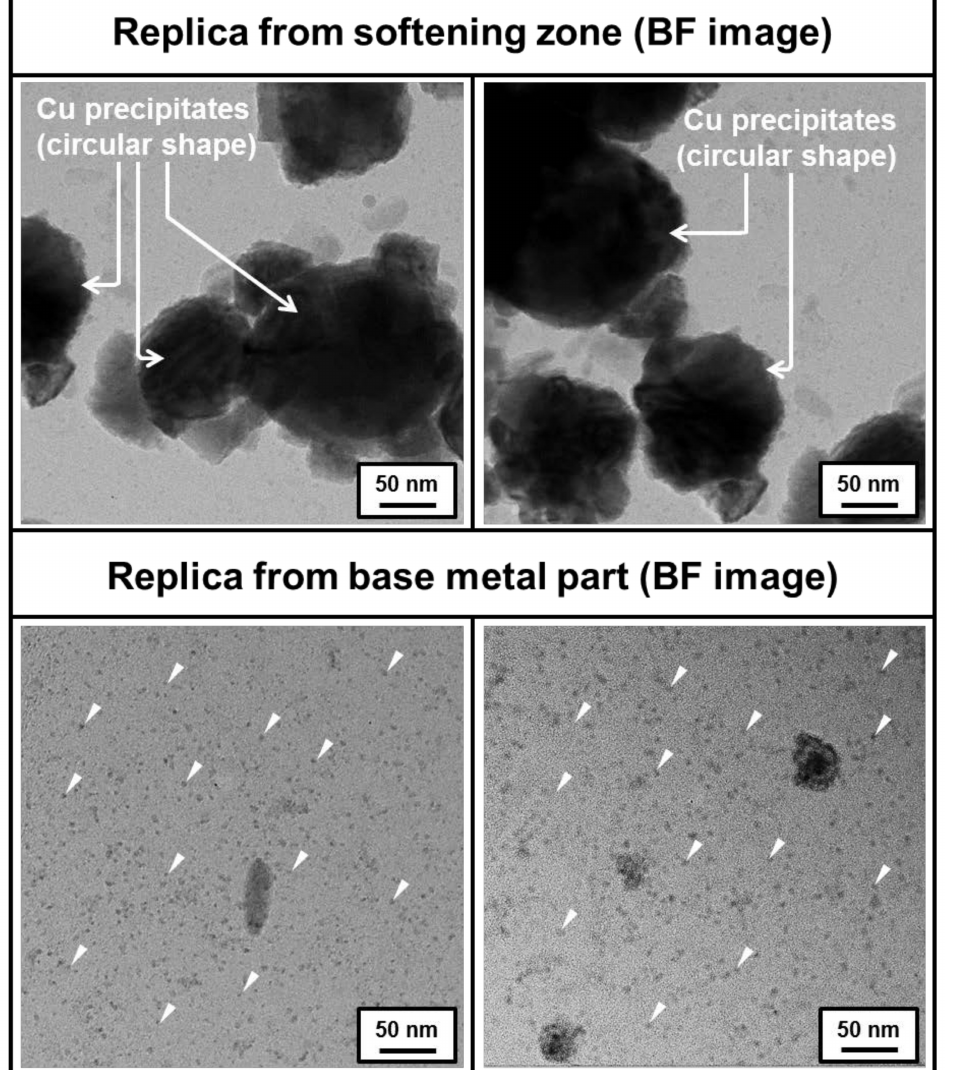
Figure 15. Comparison of TEM micrographs obtained from the replica method for the softening zone and the base metal region of P21 steel after laser-assisted heat treatment at 1473